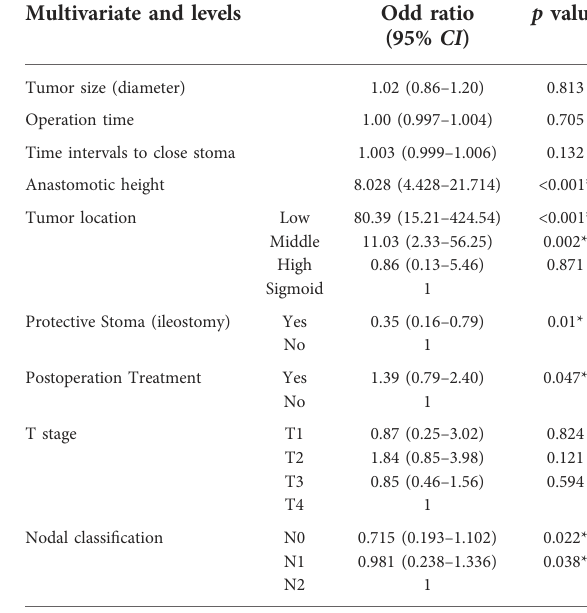
TABLE 4 Result of multivariate analysis.